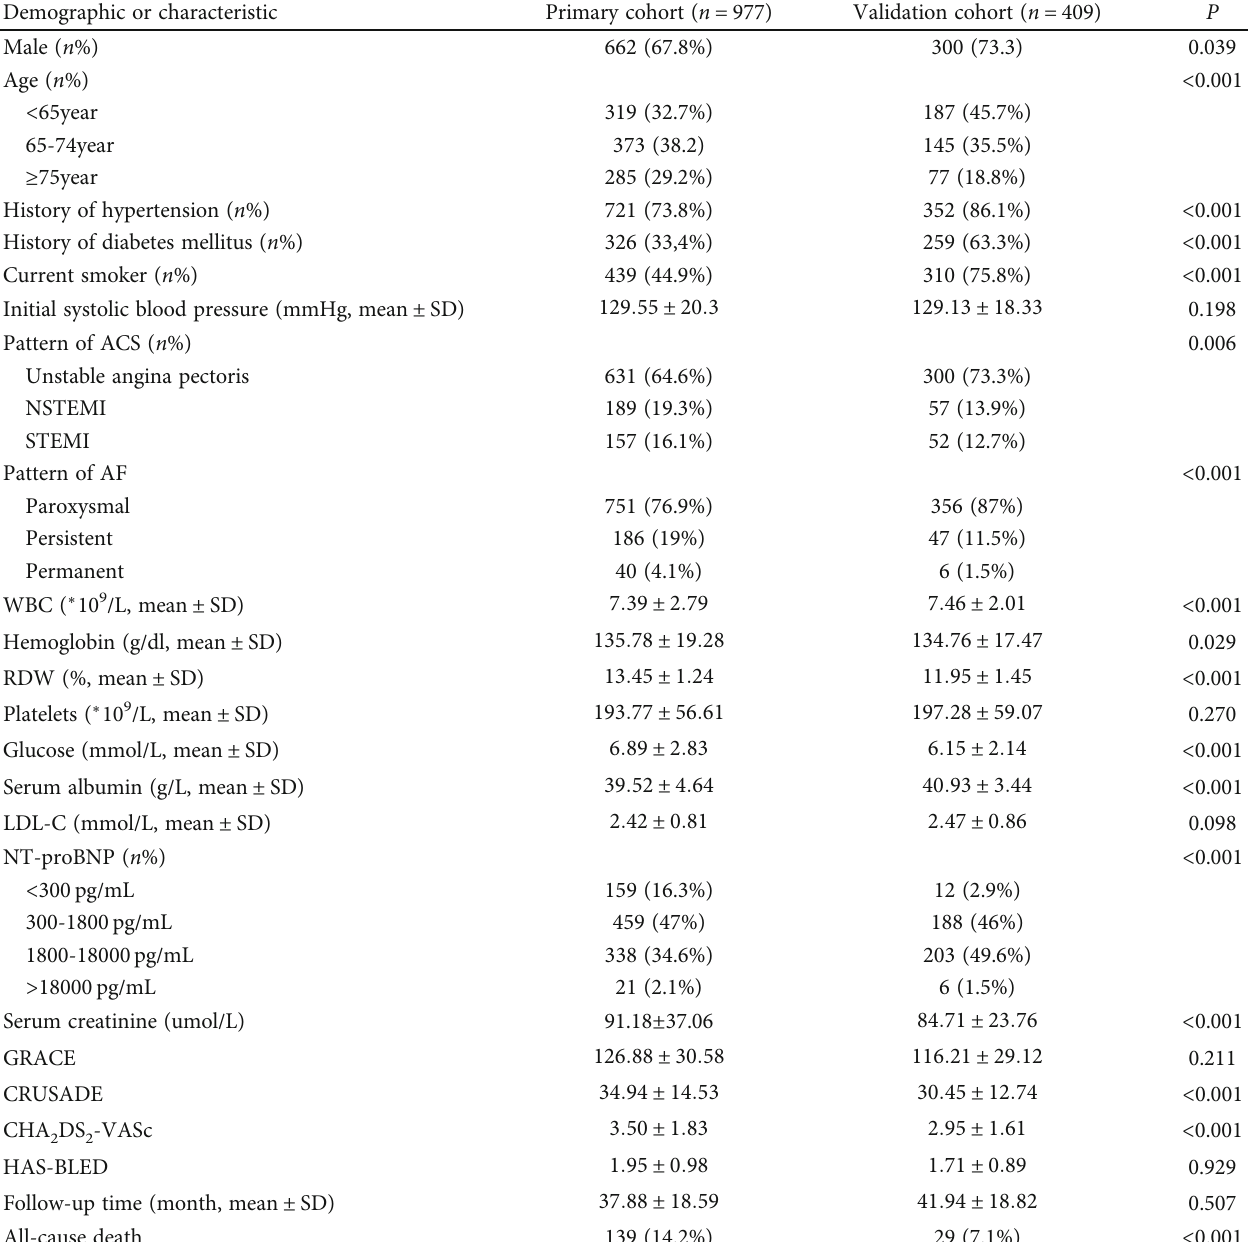
Table 1: Patient demographics and clinical